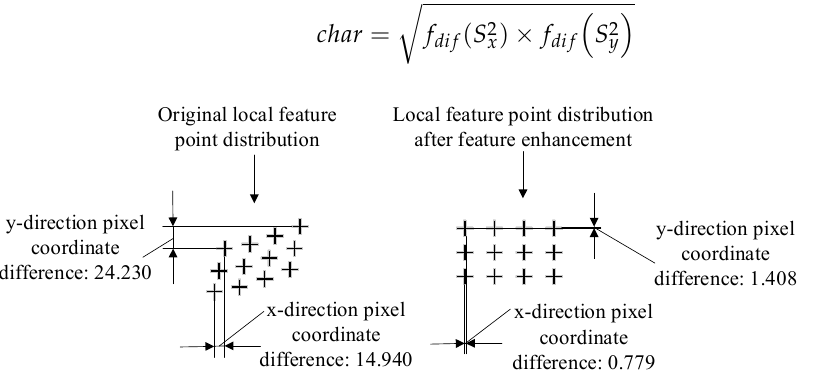
Figure 6. Comparison before and after scene characteristic enhancement. (Symbols + in the image are the locations of feature points). In Equation (15), S 2 is the variance of pixel coordinates x of feature points, S 2 is the variance of pixel coordinates y of feature points. The whole equation is the geometric mean of f dif and f dif . f dif is a normalization function considering the scene size and image size parameters. Since different image resolutions have different sizes, the variance size of the pixel coordinate distribution is not consistent. In order to unify the description, the variance value needs to be normalized, f dif as shown in Equation (16).